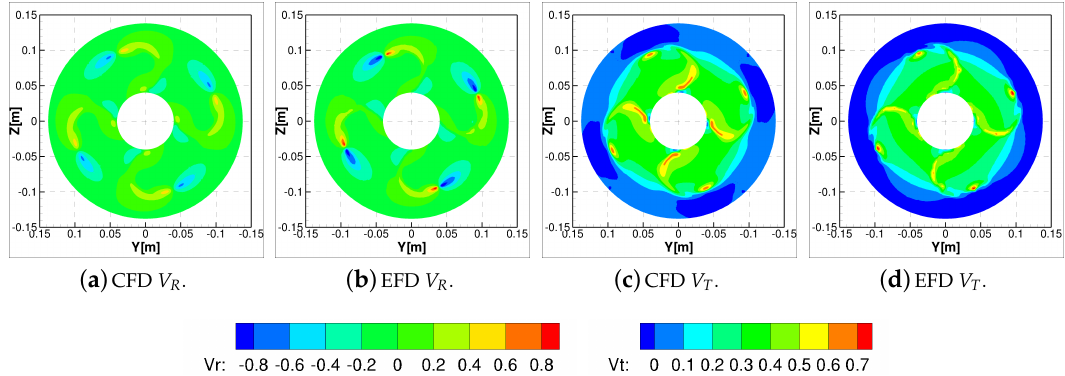
Figure 12. Circumferential axial velocity average for no-duct configuration.